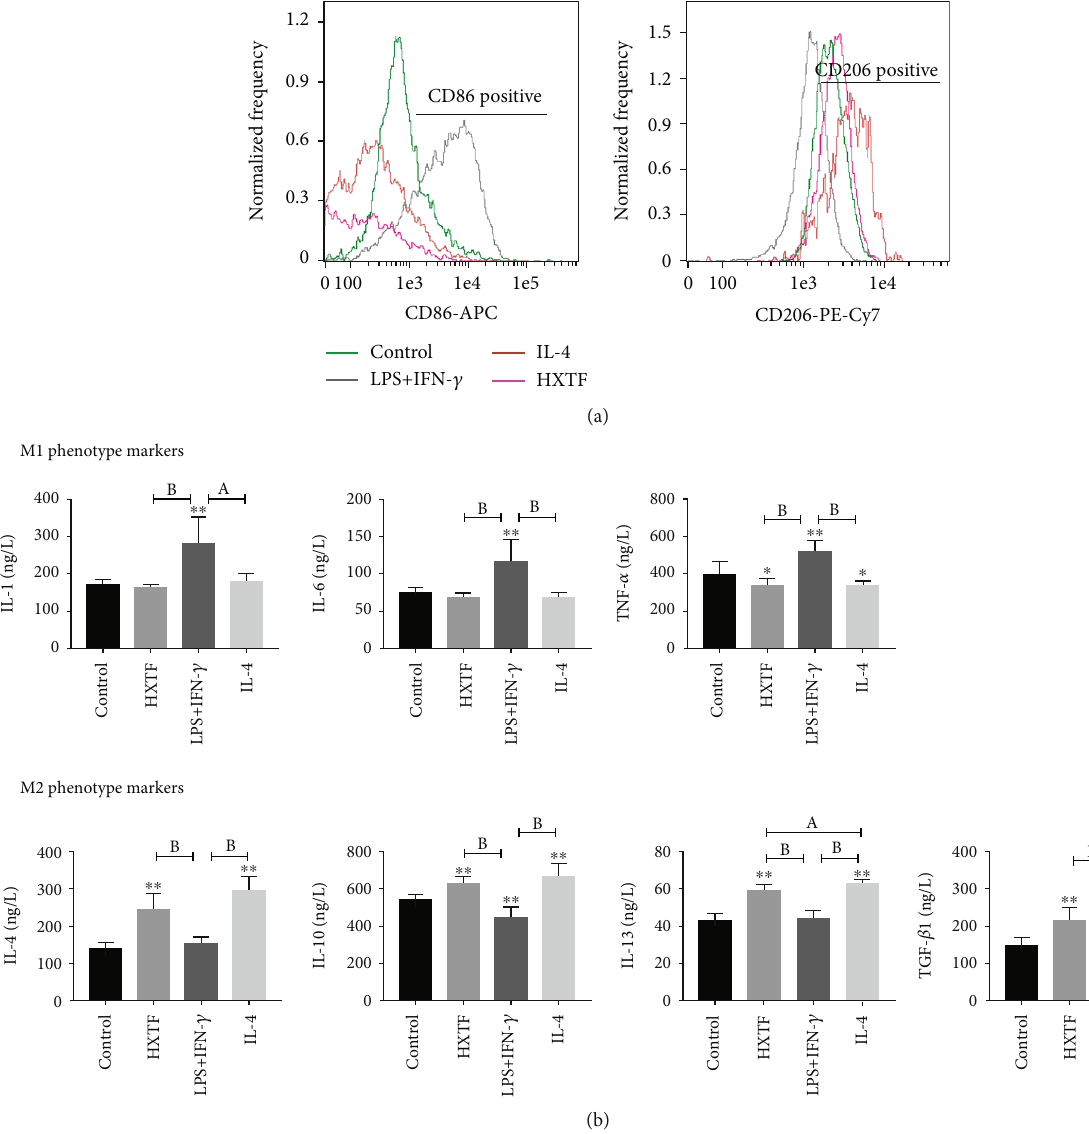
Figure 2: E ff ects of HuoXueTongFu Formula (HXTF) on macrophage polarization. RAW264.7 macrophages were incubated during 12h with the control DMEM solution, LPS+IFN- γ , IL-4, and HXTF, respectively. (a) Flow cytometry analysis of M1/M2 marker CD86 and CD206 expression. (b) ELISA analysis of M1/M2 gene marker expression on macrophages. All values are expressed as mean ± S : E : ( n = 3 experiments). ∗ p < 0 : 05 , ∗∗ p < 0 : 01 , a p < 0 : 05 , and b p < 0 : 01 , comparison of the designated two